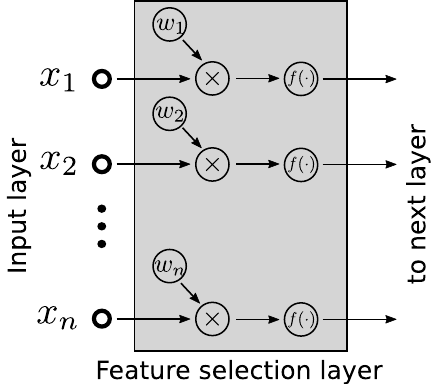
Figure 1. The network structure for the feature selection layer.